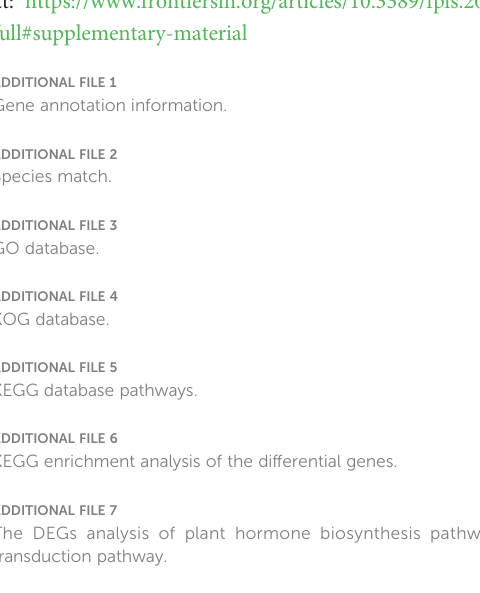
ADDITIONAL FILE 7 The DEGs analysis of plant hormone biosynthesis pathway and signal transduction pathway. ADDITIONAL FILE 8 The number of differential TFs for